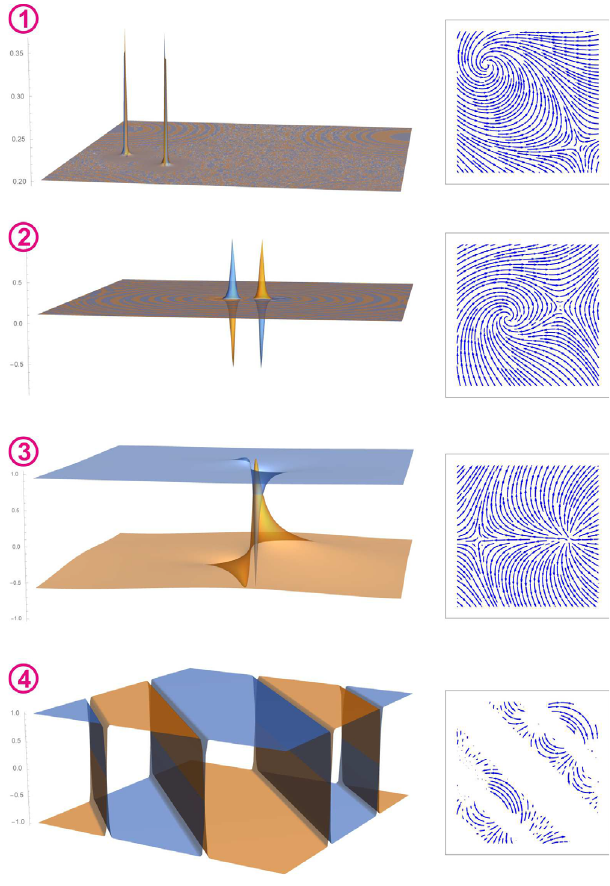
Figure 1. (color online) Inhomogeneous states in 2D system of charged hard-core bosons. The left panels show local charge den- sity n i = σ zi = cos θ i . The di ff erence of sublattice states is clearly evident in the cases 2, 3 and 4. The right panels show phase flow of planar components of the pseudospin, σ xi and σ y i . The phase flow reveals the vortex-antivortex pair structure in the core of in- homogeneity of the local charge density in the cases 1, 2 and 3. The parameters of the model are: 1) n = 0 . 2, λ = 0 . 5 (FM phase); 2) n = 0 . 1, λ = 0 . 9 (FM phase); 3) n = 0 . 2, λ = 1 . 5 (FIM phase); 4) n = 0 . 0, λ = 1 . 5 (AFM phase). These sets of parameters are denoted with numbers 1-4 on the ground-state phase diagram in figure